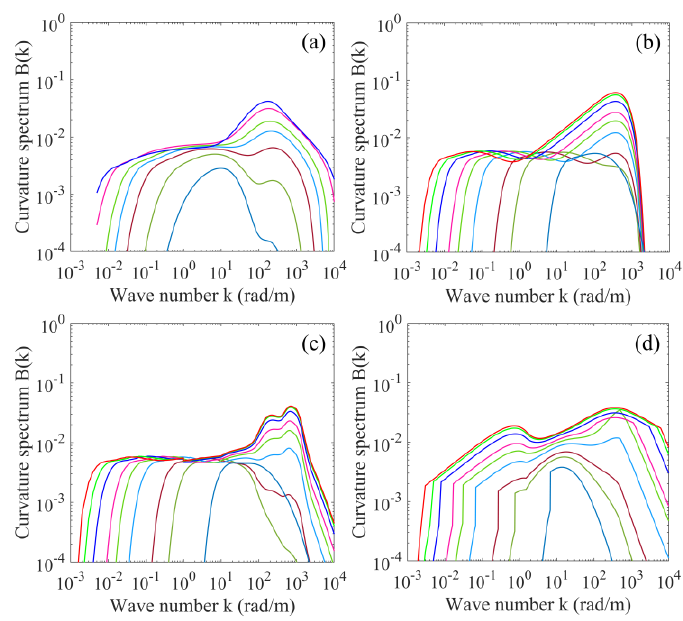
Figure 1. Azimuthally integrated ocean surface curvature spectra B ( k ): ( a ) The D spectrum with wind speed fluctuation of 1.5 m / s standard deviation, ( b ) the E spectrum, ( c ) the K spectrum, and ( d ) the H spectrum. The lines from inside out correspond to wind speeds of 1, 3, 5, 10, 15, 20, 30, 40, and 50 m / s. Even more remarkably, the four spectral models are di ff erent from each other in many